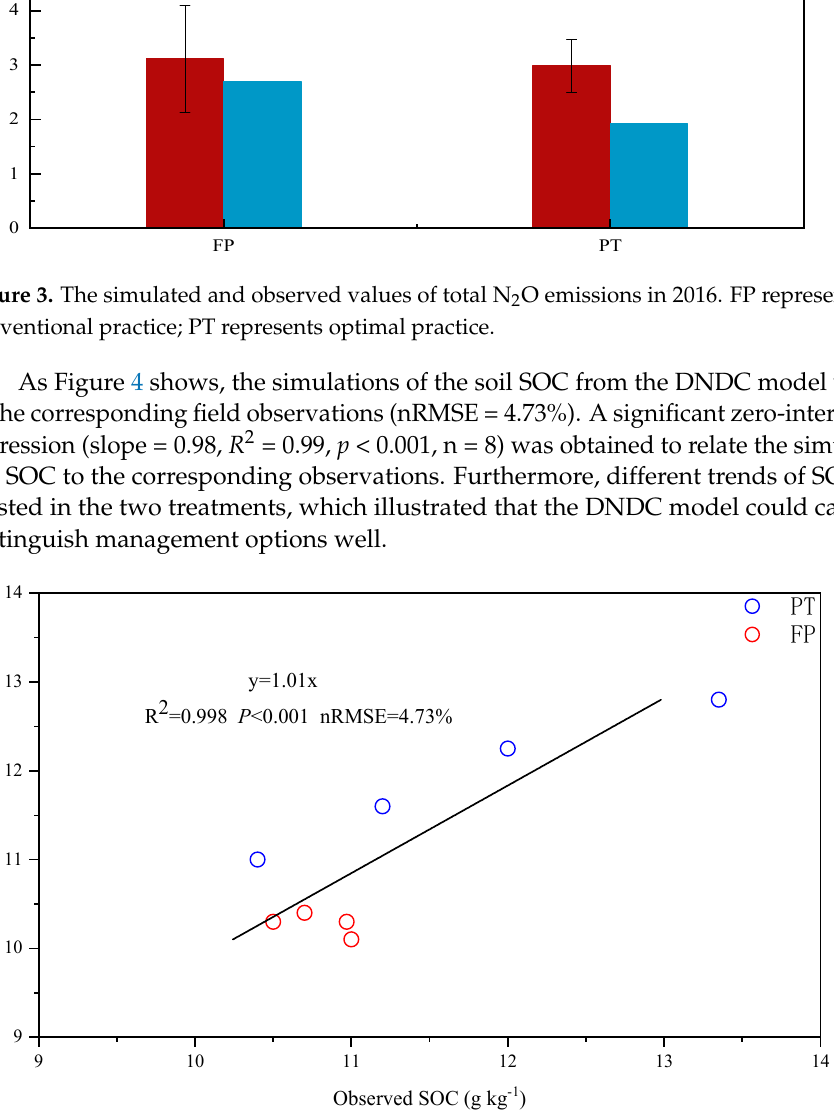
Figure 4. Comparison of simulated and observed soil SOC (0 − 10 cm) during 2015 − 2017.